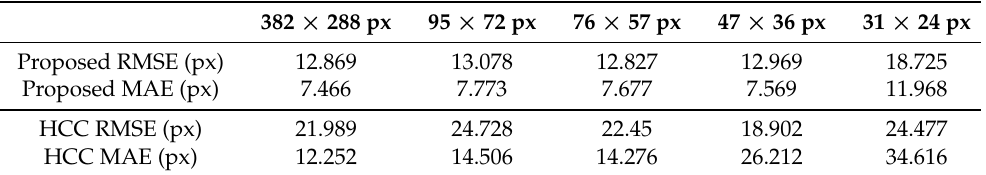
Figure 10. Distribution of correlation values for displacements greater 12 pixel for the original resolution (382 288 pixel). × Table 2. Root mean square error (RMSE) and mean absolute error (MAE) for the proposed and Haar–Cascade based